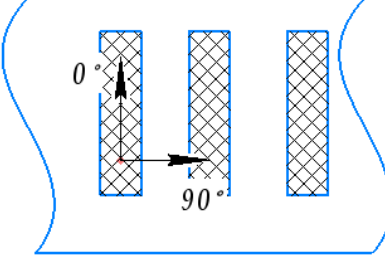
Figure 6. Direction diagram φ to the point of analysis.